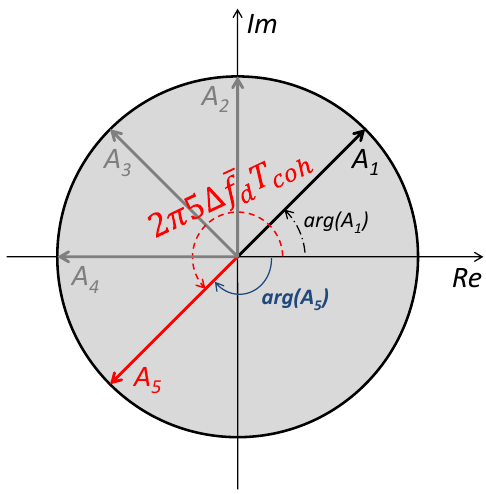
Figure 3. Limit of usable spans in Modified Generalized Differential Combination (MGDC)